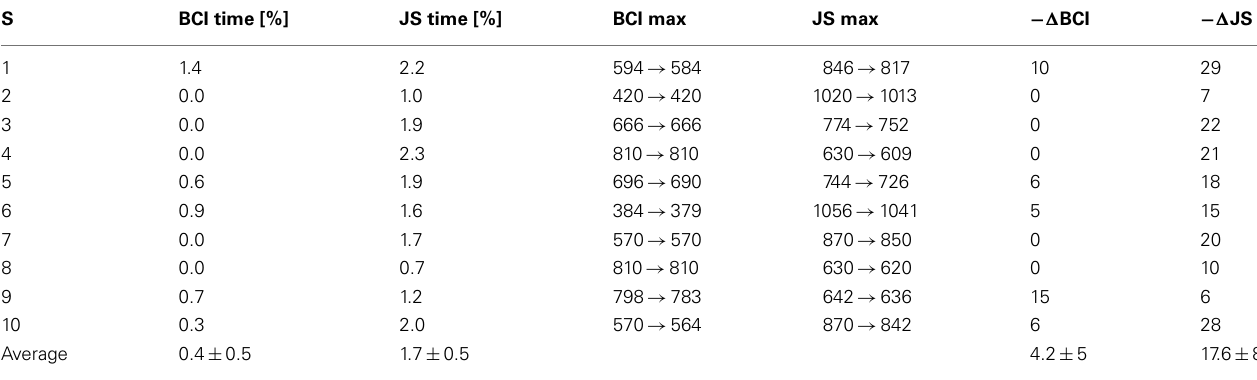
Table 5 |Activation of short term measures and their